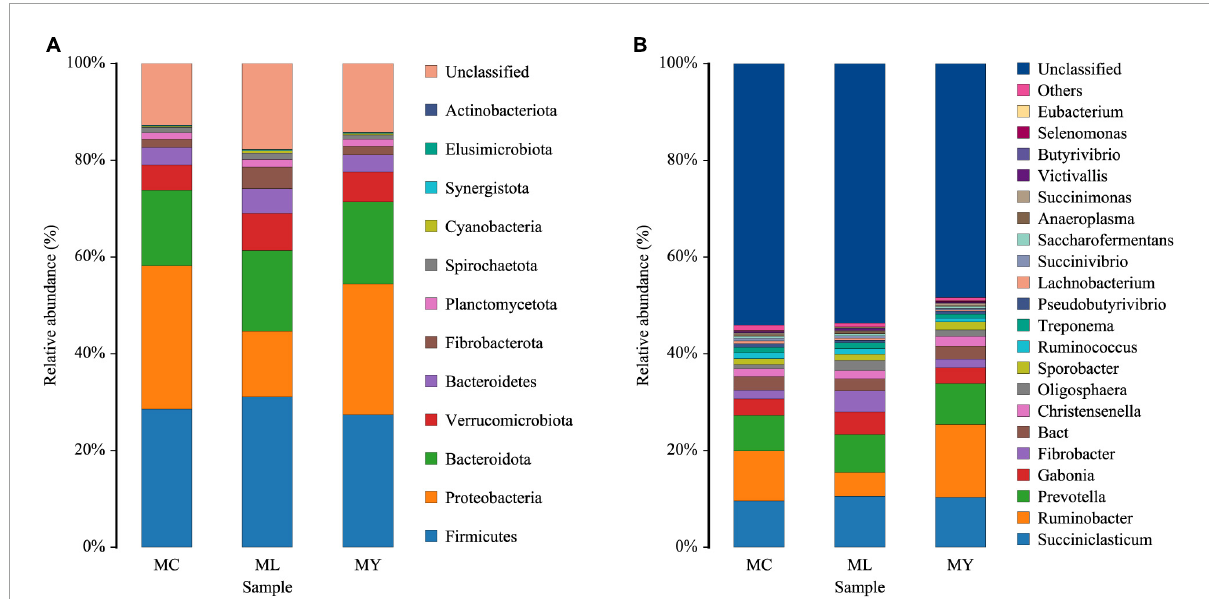
FIGURE3 The relative abundances of ruminal bacterial community at (A) phylum level and (B) genus level (relative abundance more than 0.1%). Colors of block represent species, and the height of the block represents the proportion of the species. MC, control group ( n = 9); ML, active dry yeast group ( n = 9); MY, yeast culture group ( n =